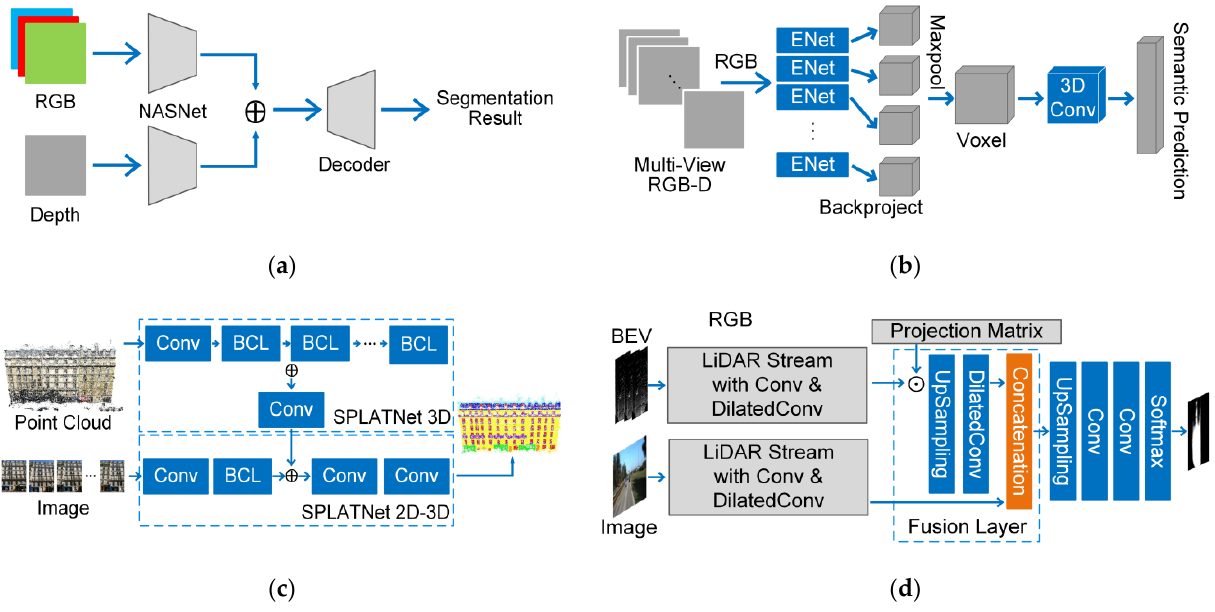
Figure 3. The representative segmentation methods using one-stage feature-based fusion strategy. ( a ) The method achieving depth completion and semantic segmentation by the late fusion manner; ( b ) 3DMV; ( c ) SPLANet; ( d ) TSF-FCN.